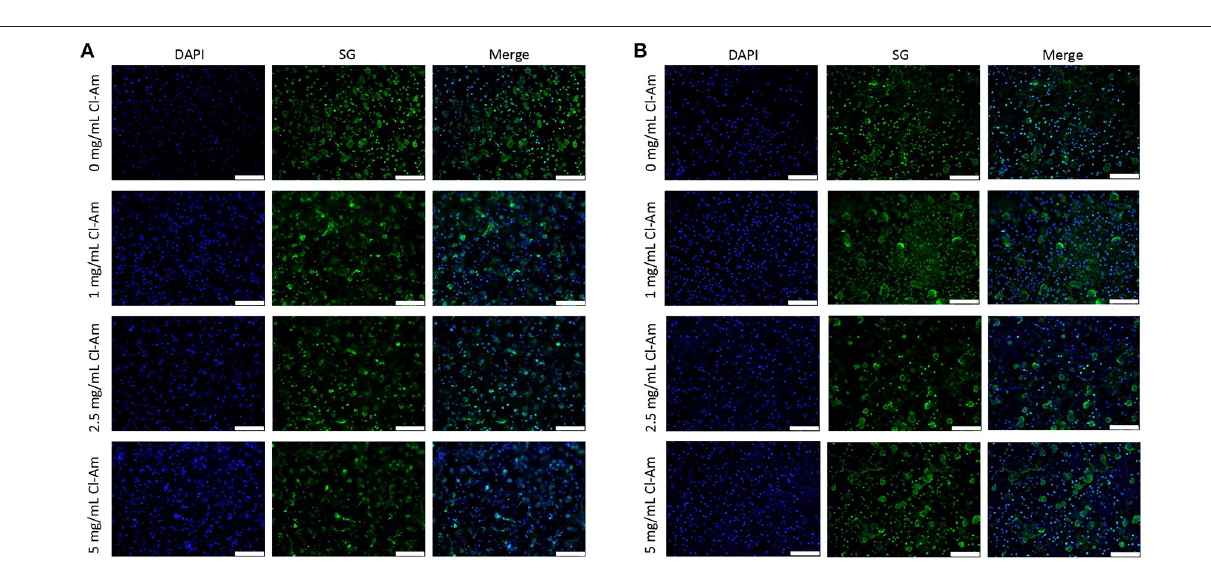
FIGURE 6 | Neutrophils interacting with Cl-Am eluting templates exhibit equivalent degrees of NETosis at 6h. Representative fluorescent micrographs of (A) SD and (B) LD templates indicate near equivalent degrees of NETosis based on drug content (scale bars = 100 µ m). Blue is DAPI. Green is